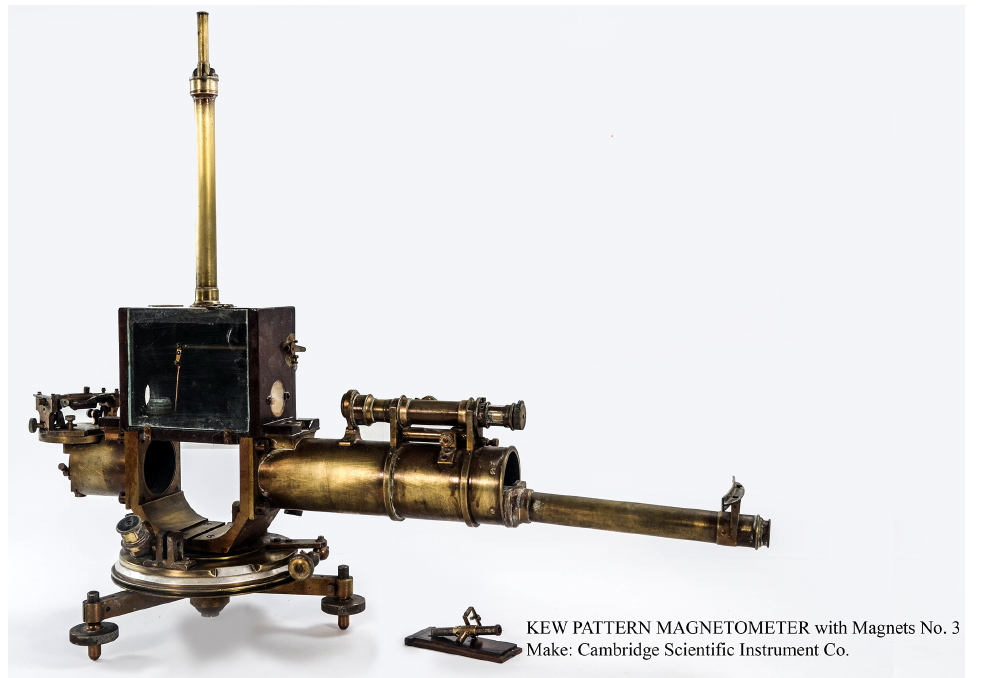
Figure 24. Kew pattern magnetometer with magnets no. 3 (courtesy of Colaba–Alibag Observatory).